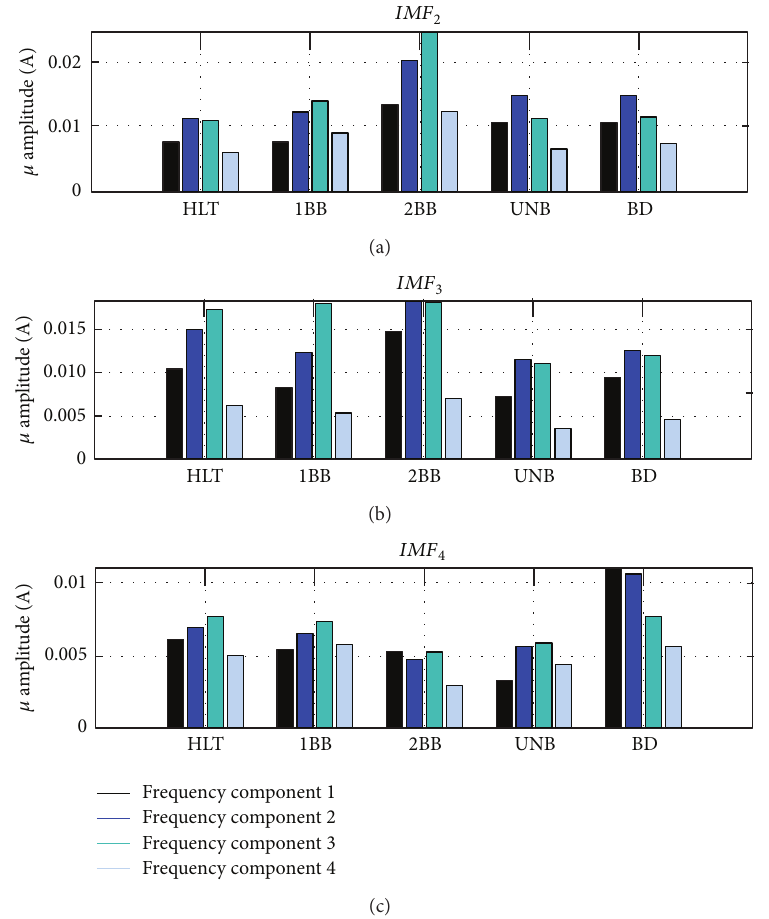
Figure 12: Frequency components estimation through ADALINE for different